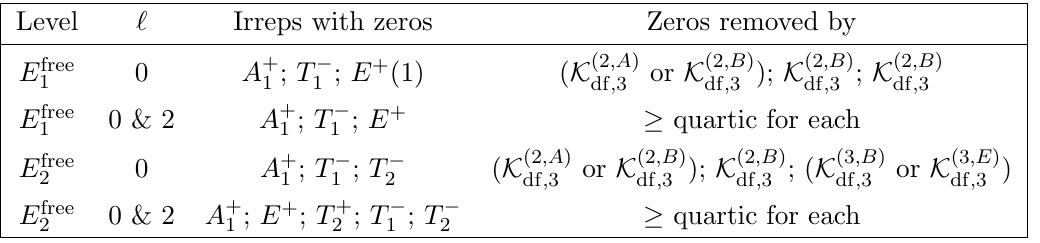
Table 3. Irreps in which free zeros appear for the (cid:12)rst two excited levels when = 0. The K df ; 3 \(1)" in the (cid:12)rst row denotes that the E free , ‘ = 0 free zeros in the E + irrep are single roots with 1 unphysical residue; all other free zeros in the table are (unphysical) double roots. Also noted are the lowest-order terms in the threshold expansion of that remove the free zeros. The notation K df ; 3 \ quartic" indicates that a term of at least quartic order is needed. Note that cubic-order terms (cid:21) are needed to remove the E free , ‘ = 0 free zeros in the T (cid:0) irrep, as neither of the quadratic terms 2 2 (2 ;A ) (2 ;B ) and has nonzero eigenvalues in this df ; 3 df ; 3 K K